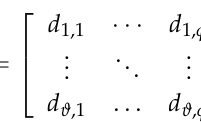
This divides the range of the LiDAR detection into a conical space of ϑ × φ . Although the azimuth of the point from the same detector module is different after a period, every point falls into a polar grid with the roadside LiDAR in the center, as is shown in Figure 6. Because of the characteristics of LiDAR rotational scanning, the rectangular-grid method has a high density of point clouds at close ranges and sparse point clouds at long ranges. The polar grid that is proposed can ensure the same point-cloud density for each grid, which allows us to better model the